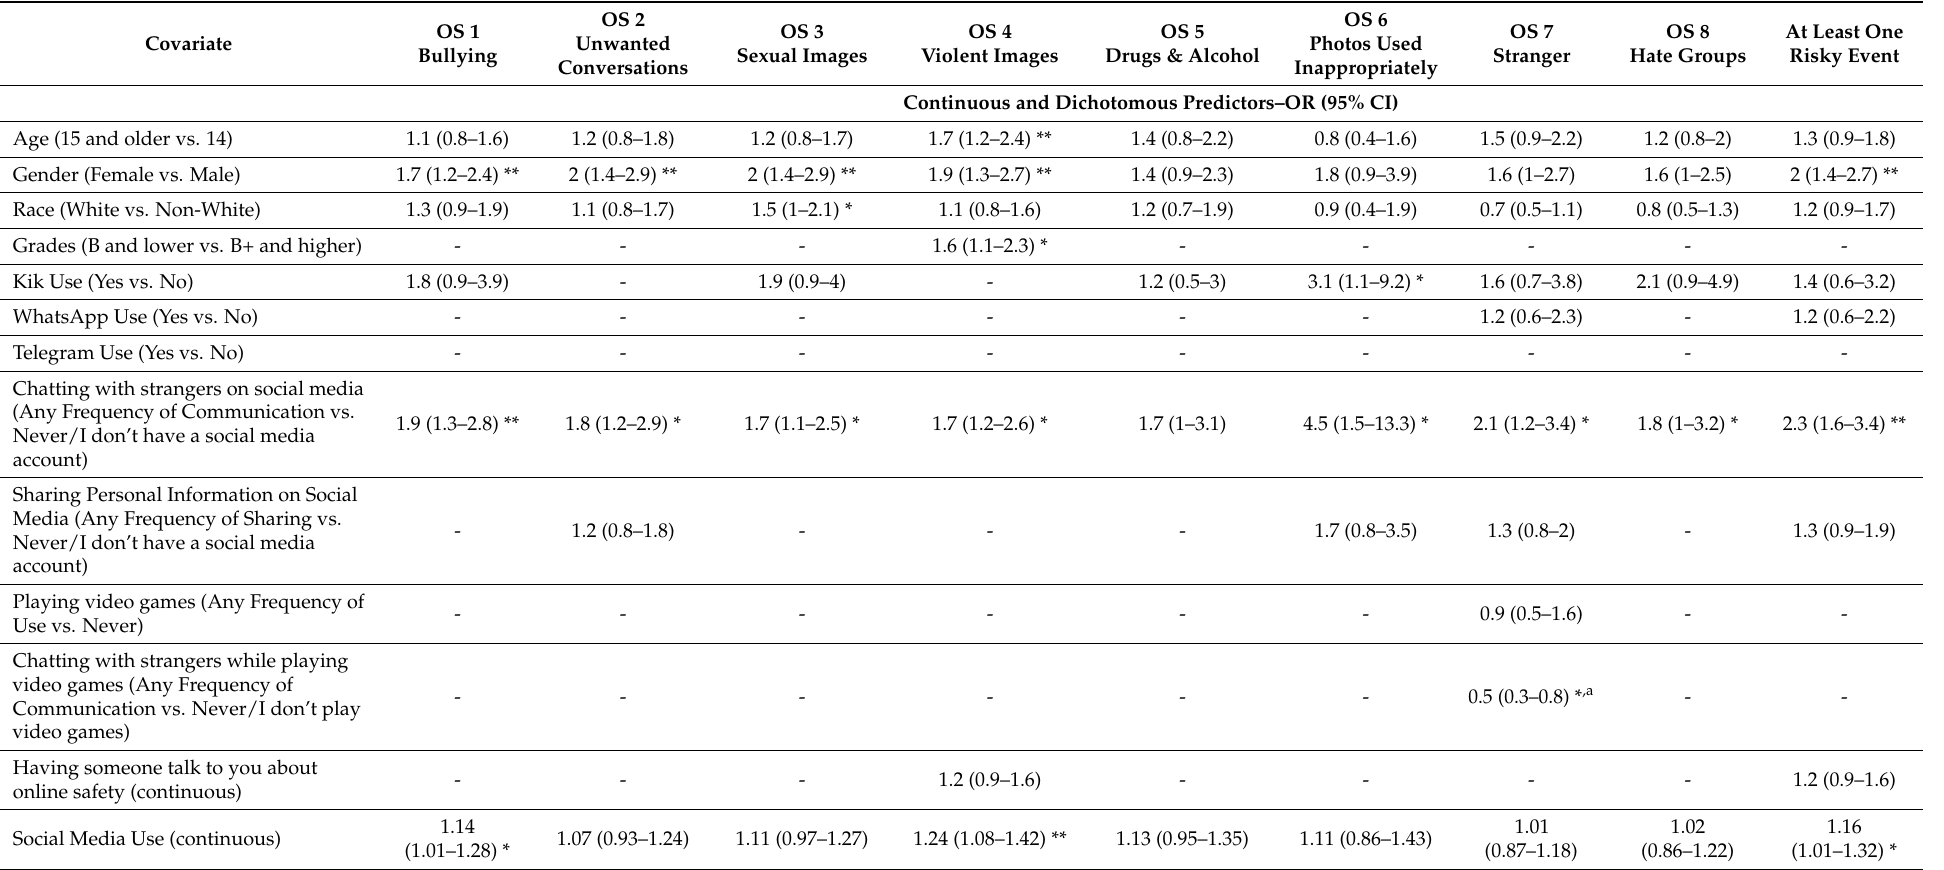
Table 3. Multiple Logistic Regression